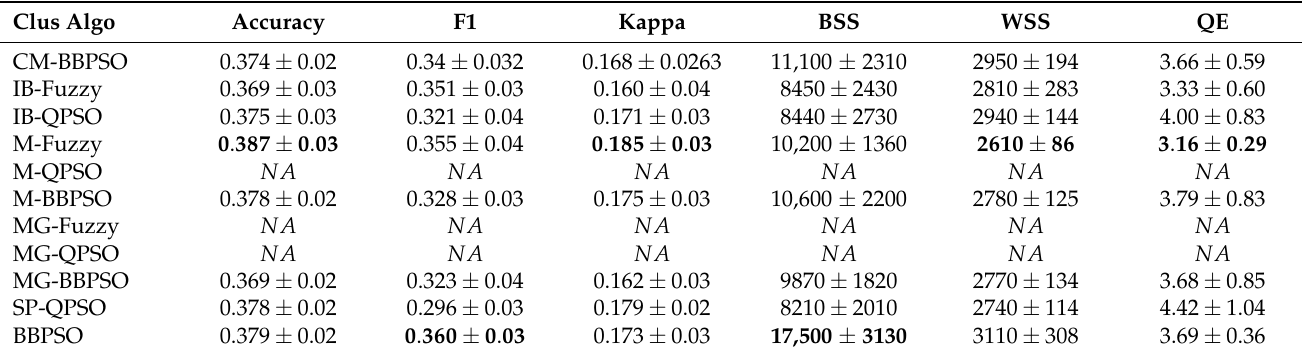
Table 4. Performance of CM-BBPSO and other clustering algorithms on Vehicle dataset with the best result produced by the algorithm presented in